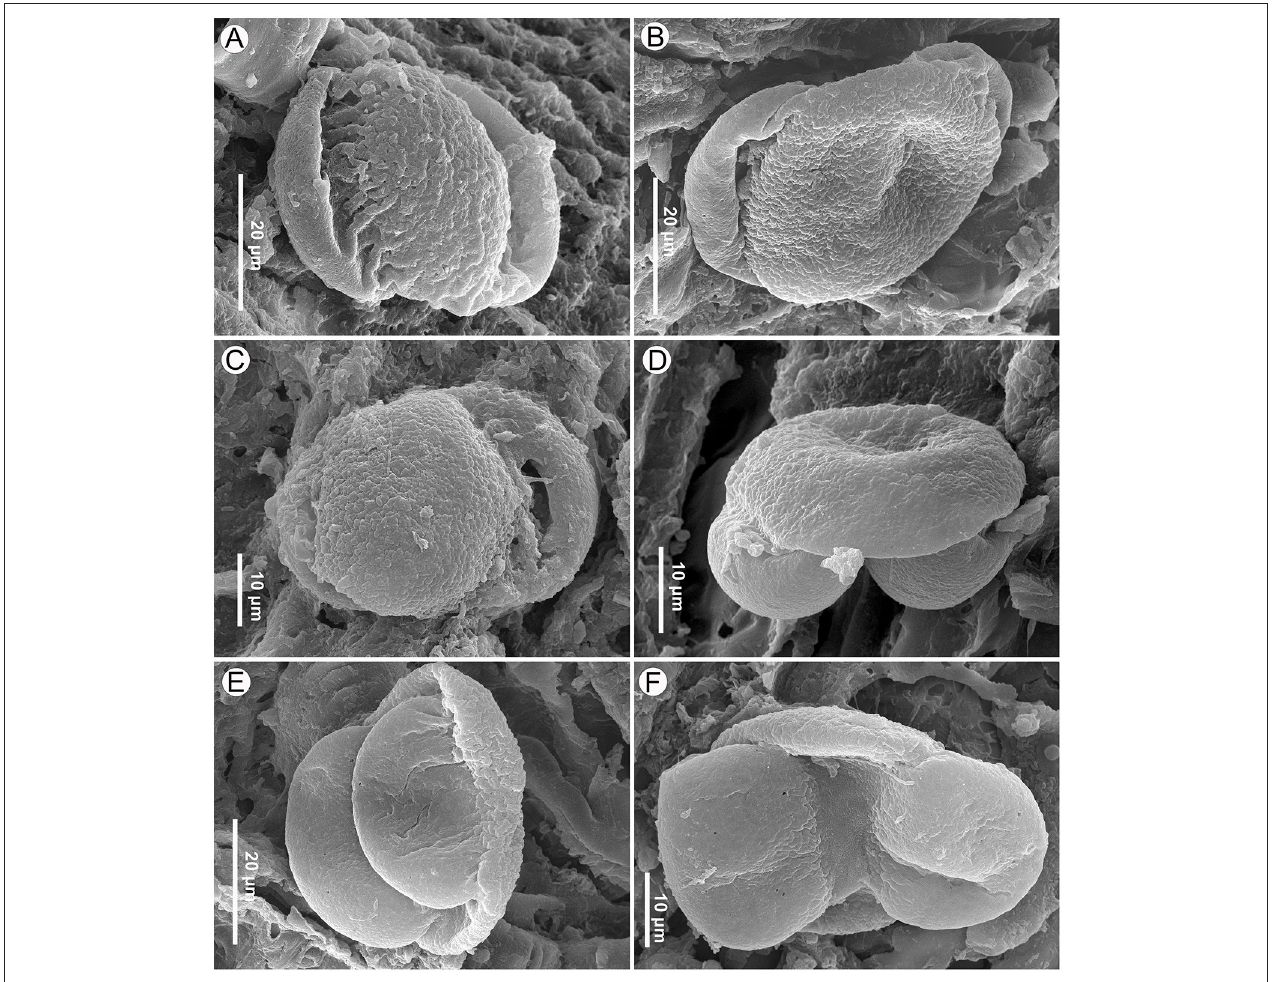
FIGURE 11 | Pinus pollen on the seed scale surface of Pinus prehwangshanensis sp. nov., specimen MMRH171, SEM. (A) ? Pinus pollen, proximal view, granulate-foveolate, coarsely rugulate cappa sculpture, and deeply folded rugulae in the cappa-saccus transition are seen. (B,C) Pinus pollen, proximal view, verrucate-rugulate cappa sculpture is seen. (D,E) Pinus pollen, lateral view, a sharp change in the sculpture pattern is seen in the cappa-saccus transition. (F) Pinus pollen, distal view, the leptoma membrane is finely